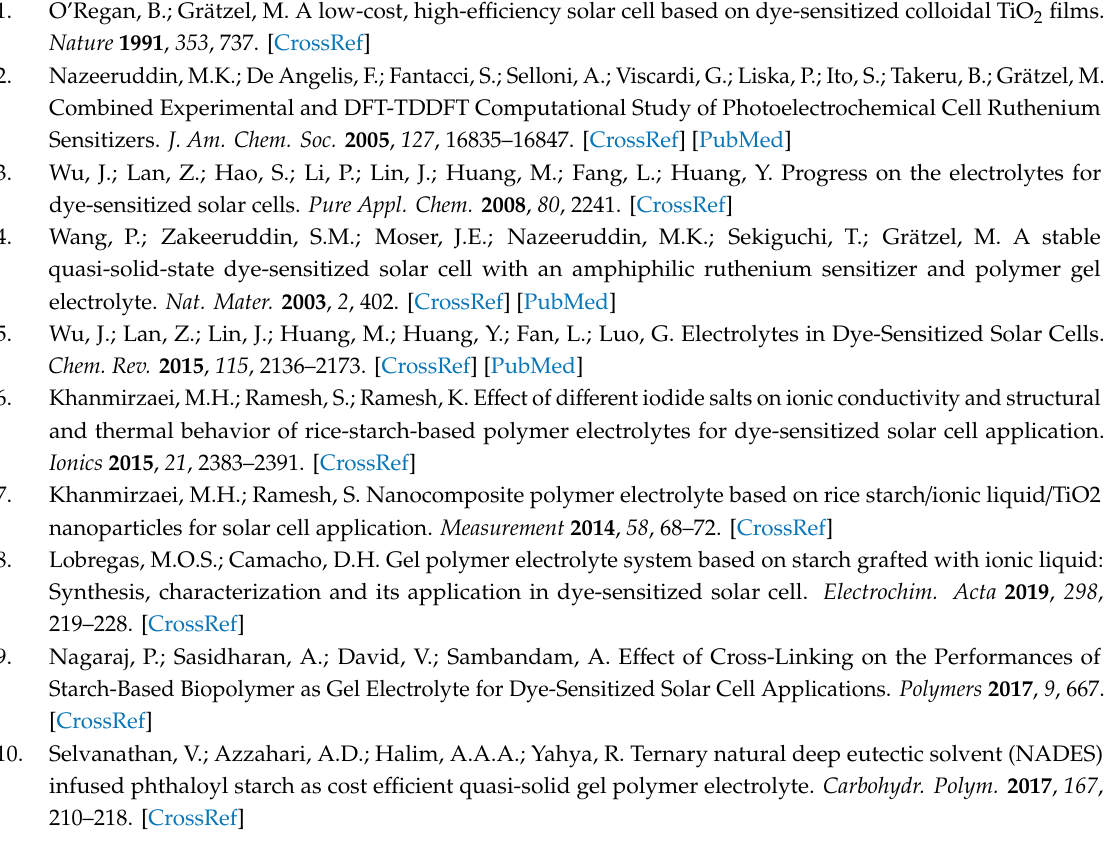
Figure S1: Amplitude sweep curves of PhSt-HEC-DMF gel electrolytes with LiI; Figure S2: Amplitude sweep curves of PhSt-HEC-DMF gel electrolytes with TPAI; Figure S3: Tack test curves of PhSt-HEC-DMF gel electrolytes with (a) LiI and (b) TPAI; Figure S4: FTIR spectra of PhSt-HEC-DMF gel electrolytes with (a) LiI and (b)